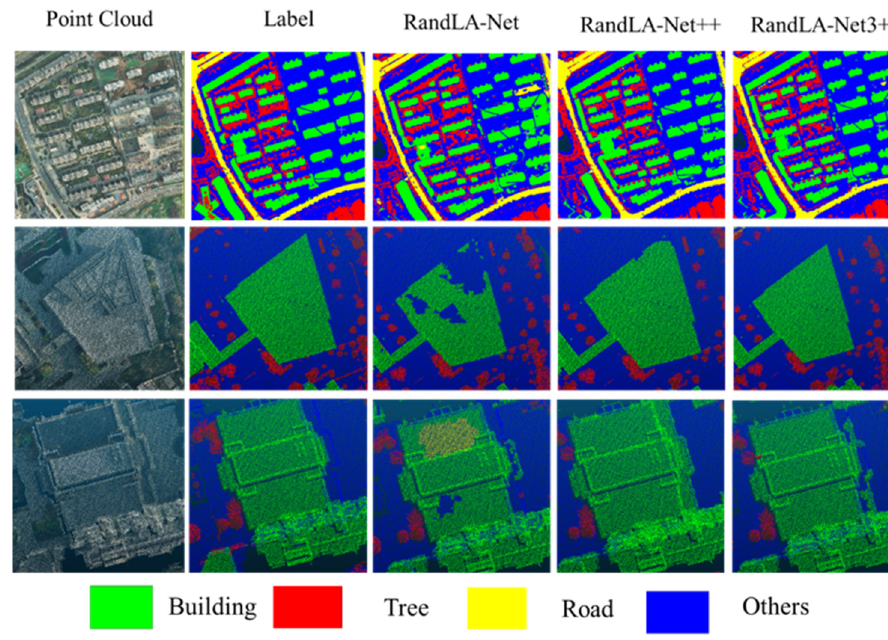
Figure 9. Partially enlarged view of the point cloud semantic segmentation results.